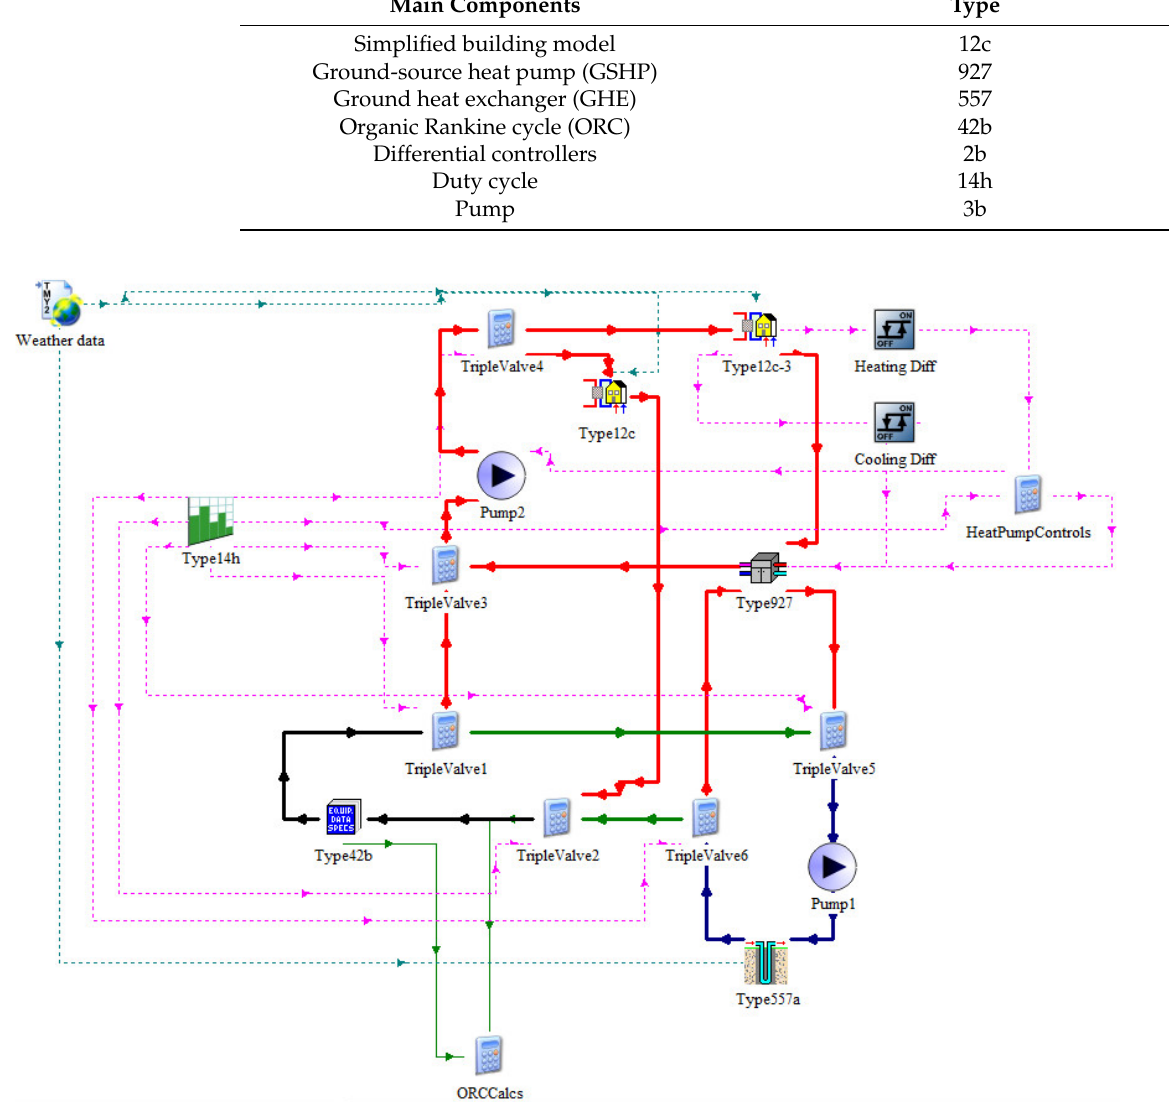
Figure 2. Flow diagram of the TRNSYS simulation model of the proposed ORC-GHE-GSHP micro-cogeneration system.